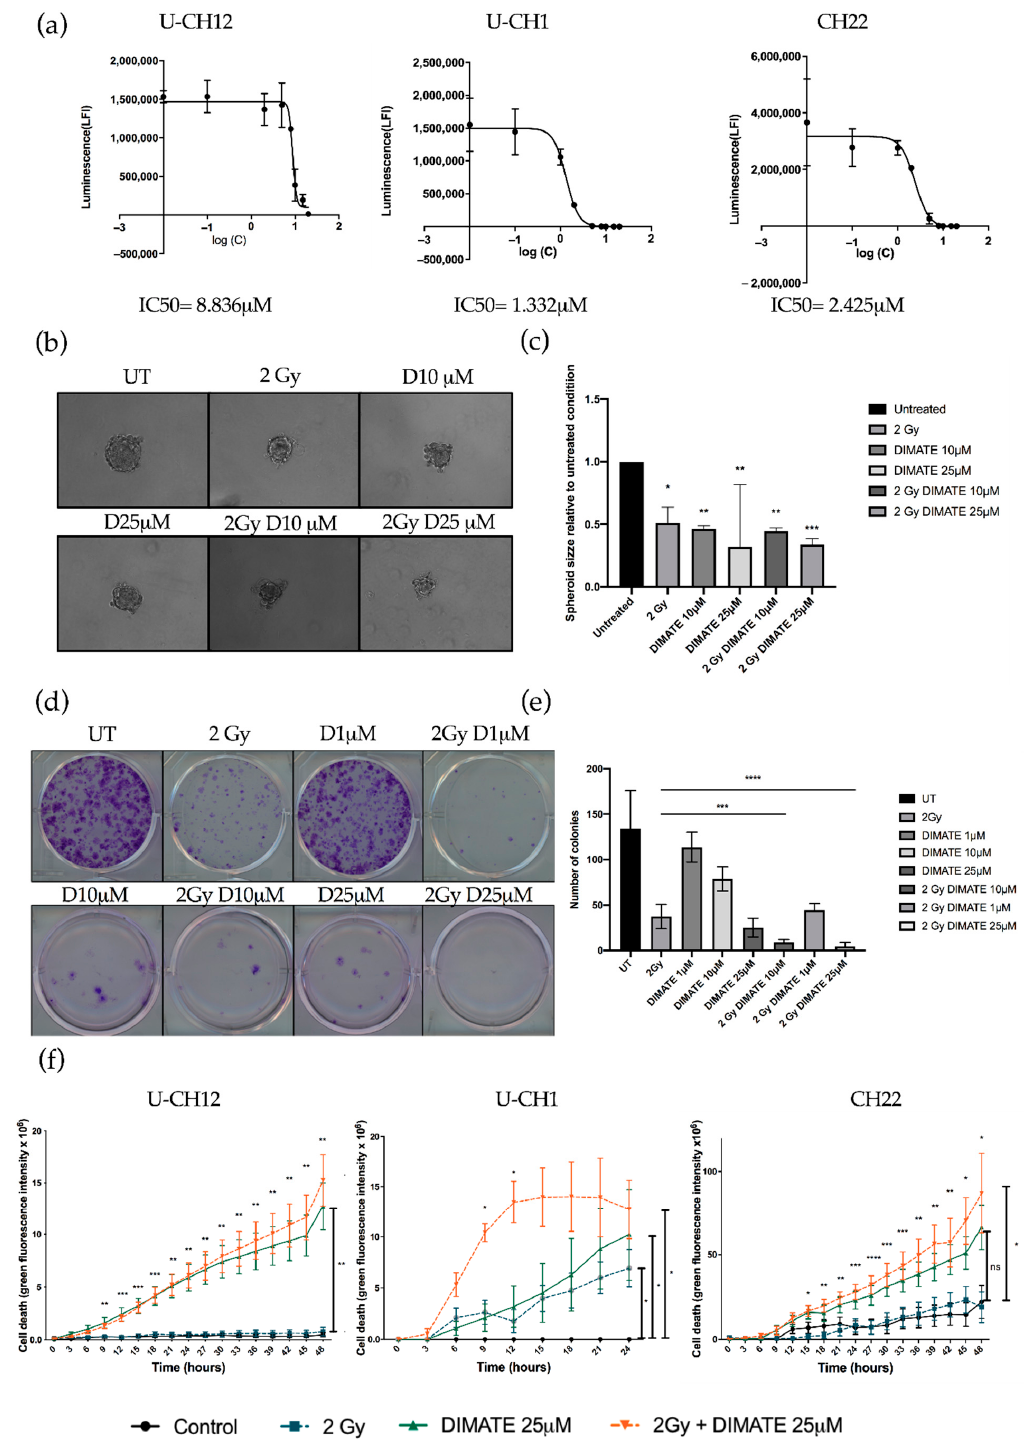
Figure 5. ALDH inhibition decreases radioresistance in chordoma: ( a ) a graph representative of three independent experiments of DIMATE IC50 in chordoma spheroids after 48 h of treatment at concentrations ranging from 0.1 to 25 µ M, ( b ) images and ( c ) a graph representative of the CH22 spheroid size relative to untreated conditions after treatment with X-rays or after a combined treatment with X-rays and DIMATE, ( d ) images and ( e ) a graph representative of the number of colonies formed in UT conditions or after treatment with DIMATE as a monotherapy or combined with 2 Gy of X-rays in CH22 spheroids, and ( f ) a graph representative of spheroid cell death over 48 h in UT conditions or after treatment with DIMATE alone or in combination with 2 Gy of X-rays. Each experiment was conducted three times in triplicate. The statistical comparison between each group was determined using a one-way ANOVA. Significant p -values are indicated as follows: p < 0.05 *, p < 0.01 **, p < 0.001 ***, and p < 0.0001